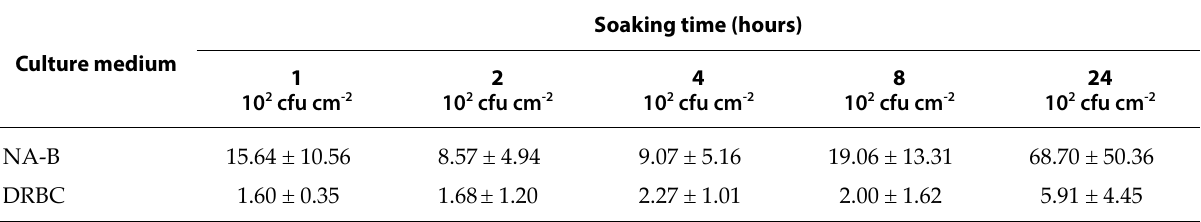
Table 3. Colony forming units (cfu) of bacteria and fungi recovered from the surfaces of containers used for soaking Shiraz